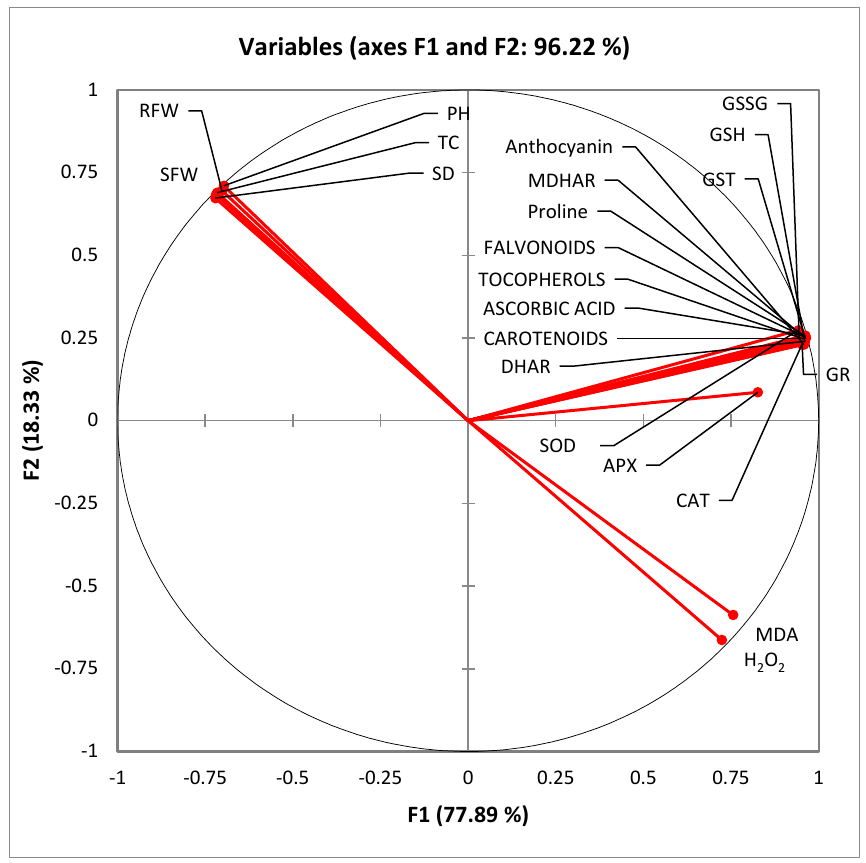
Figure 6. Principal component analysis (PCA) of various observed parameters followed in the study.